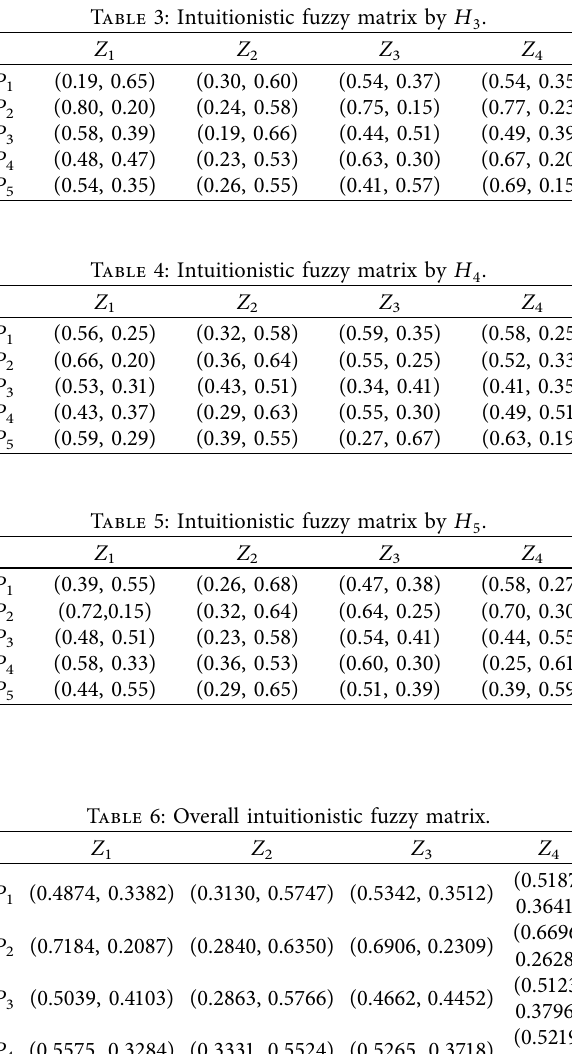
Table 3: Intuitionistic fuzzy matrix by H